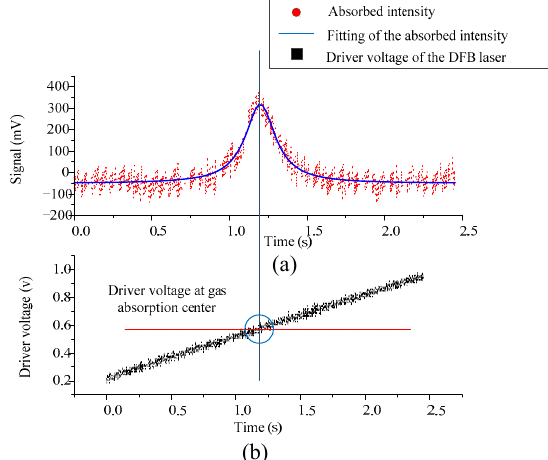
Fig. 8 Absorption laser intensity and driver voltage at gas absorption center: (a) the absorption laser intensity of the reference gas cell and (b) the driver voltage of DFB